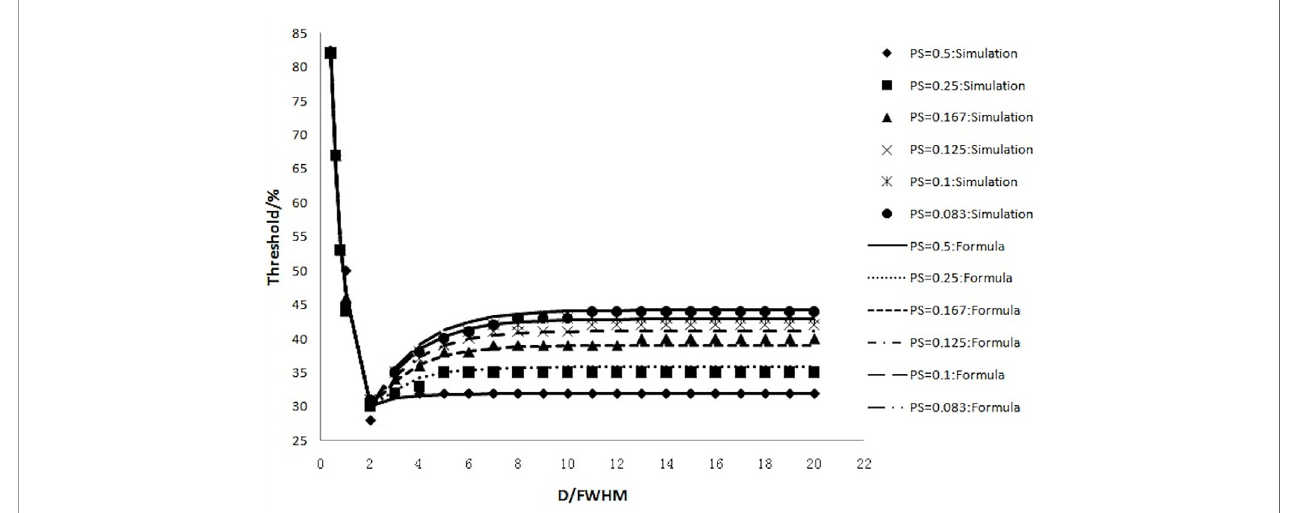
FIGURE 6 | The thresholds calculated with the formula (smooth curve) and those obtained from simulation experiments and their variation with D/FWHM.